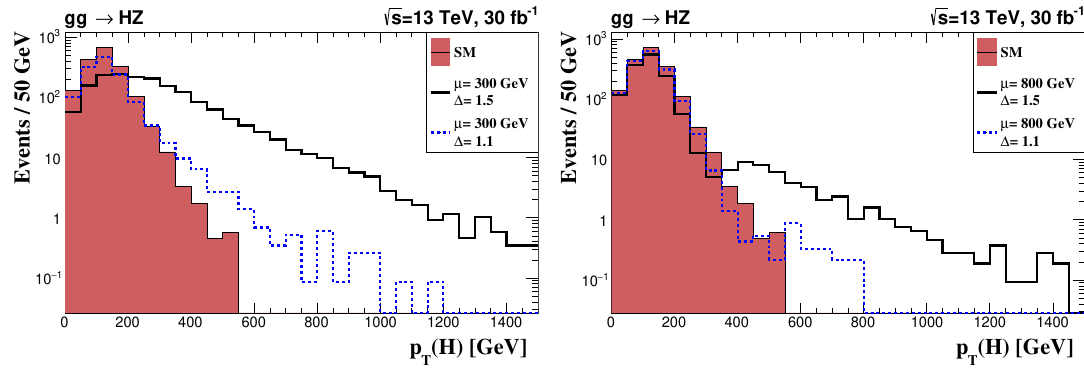
Figure 19. gg ! HZ , versus the Higgs transverse momentum, p T ( H ).